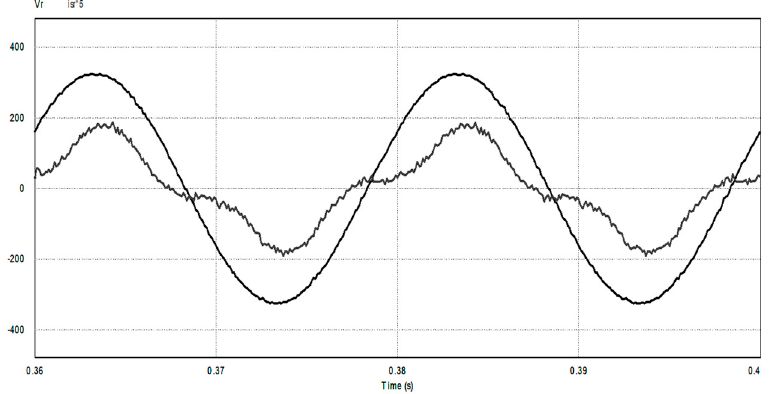
Figure 14. Case C - voltage and current in phase R .